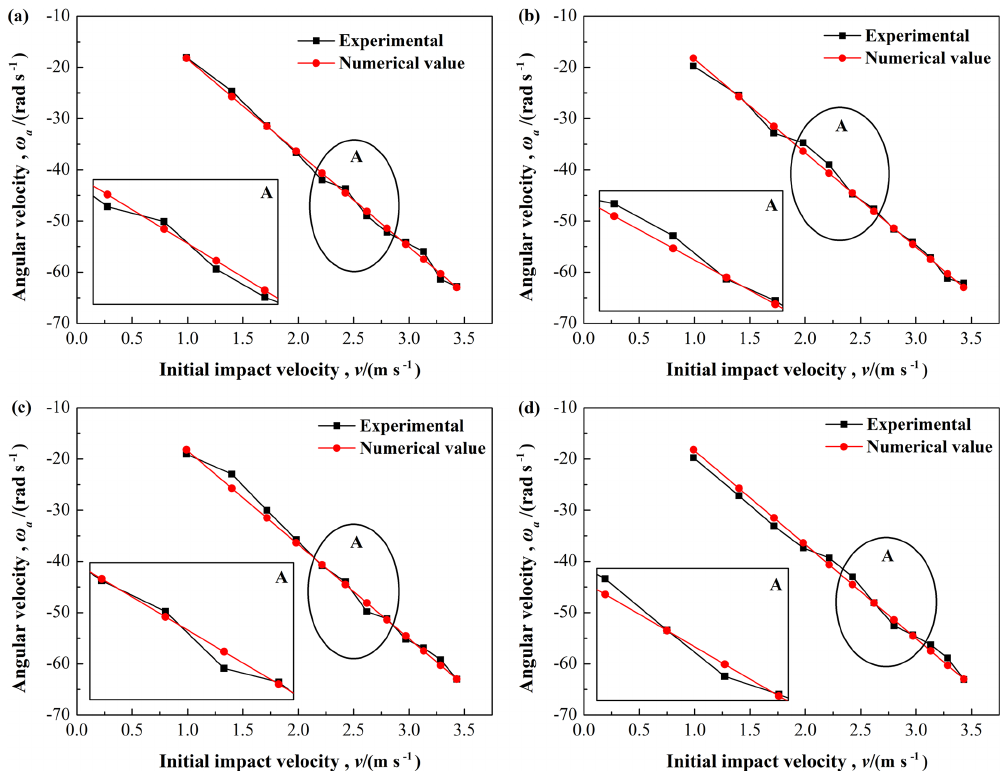
Figure 15. Comparison between the simulations and the experimental results for the rebound angular velocity: (a) ξ = 1 / 8, (b) ξ = 1 / 2, (c) ξ = 3 / 4, and (d) ξ = 7 / 8.